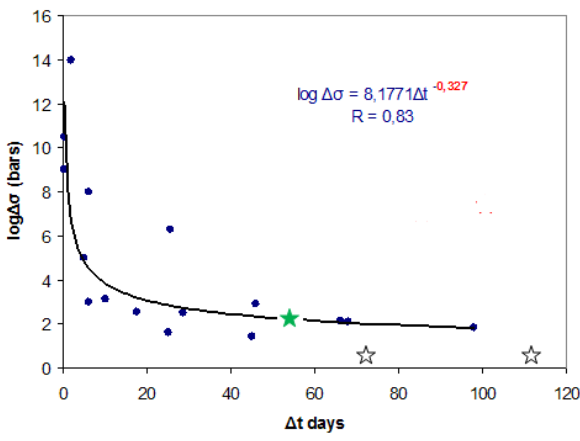
Fig. 3. The plot of the relation between the stress drop and the lead time for the earthquakes considered by Dologlou, 2010, along with the new data. A green star corresponds to the new event no. 1, while the open stars to the other two events no. 2 and 3 (Table 1). The derived power law relation along with its correlation coefficient R are displayed on the top of the